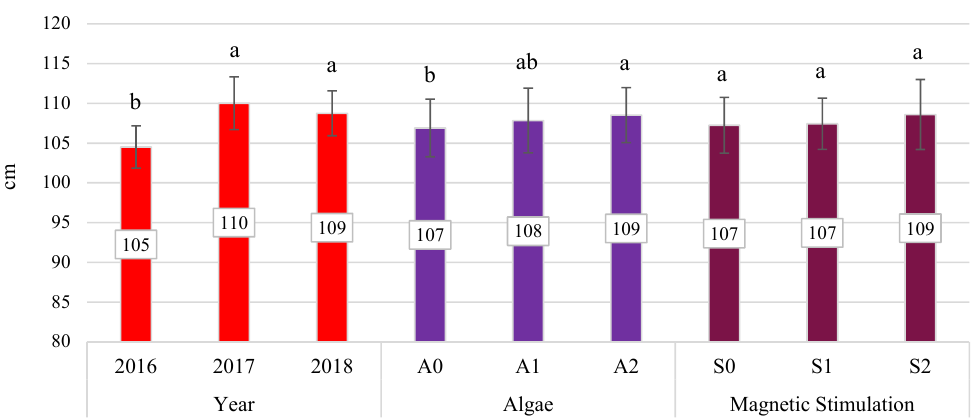
Figure 11. Effect of the alga dose and the MF exposure dose per mass of a thousand grains from 2016 to 2018. According to Tukey’s HSD (honest significant difference) test, the means marked with the same letter were not significantly different at α ≤ 0.05.